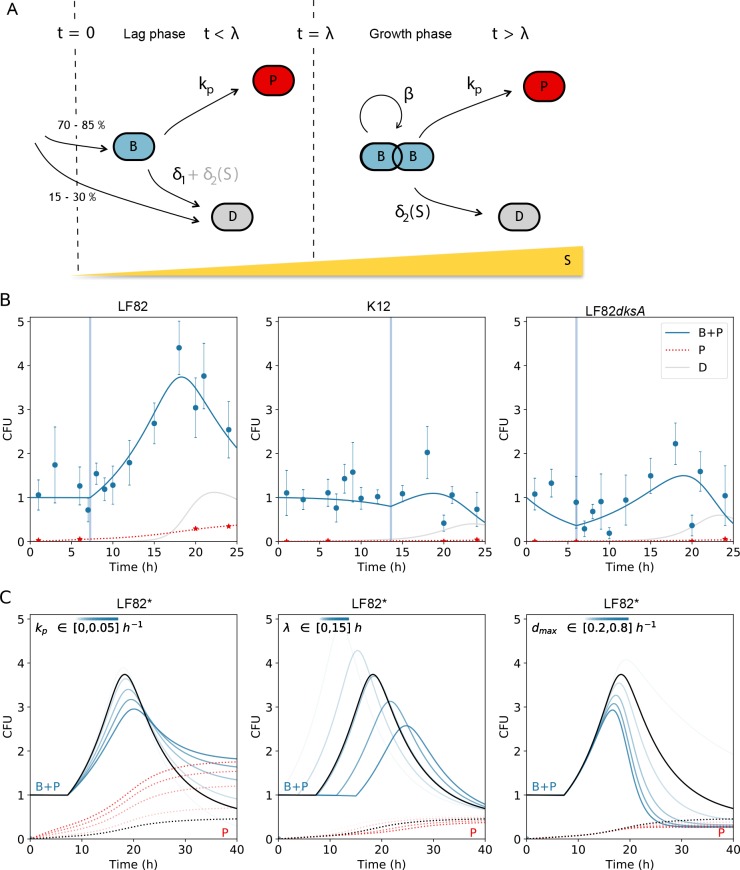
Kinetics of macrophage infection.A) Model of infection of THP1 macrophages by LF82, describing the processes of net growth, switch to persistence and stress-induced death as explained in the text. Part of the cells that enter the macrophage die at the onset of the infection (t = 0). During lag phase (0<t<λ), death either exactly compensates birth or, in the mutant lacking the stringent response, results in a negative net growth rate -δ1. Later in the infection, the net growth rate β is positive. Death rate due to stress accumulation (yellow bar) is negligible in the early stages of infection and becomes particularly important at late time points. Bacteria switch to a persistent state at a rate kp independent of the growth stage. B) Experimental measures of the infection kinetics (CFUs, circles; persister fractions, stars) collected over 24h for LF82 (this set of data is already presented on the Fig 1A), E. coli K12-C600 and LF82 dksA (data obtained on one set of THP1 macrophages in triplicates) and the best fitting parameters (S1 Table) of model eq. (1) (Methods). LF82 data corresponds to the data presented on Fig 1A, E. coli K12-C600 and LF82 dksA data are median of 3 to 5 infections per time point. Continuous lines represent total number of bacteria (B+P, continuous line) and persisters (P, dotted line). Vertical lines indicate the duration λ of lag phase. C) Projected changes in infection dynamics for ‘virtual mutants’ LF82*, obtained by varying kp, λ and dmax−the parameters that quantitatively differ between LF82 and E. coli K12-C600 –around the LF82 best fit solution (black line); colored lines correspond to parameter values within the indicated interval.